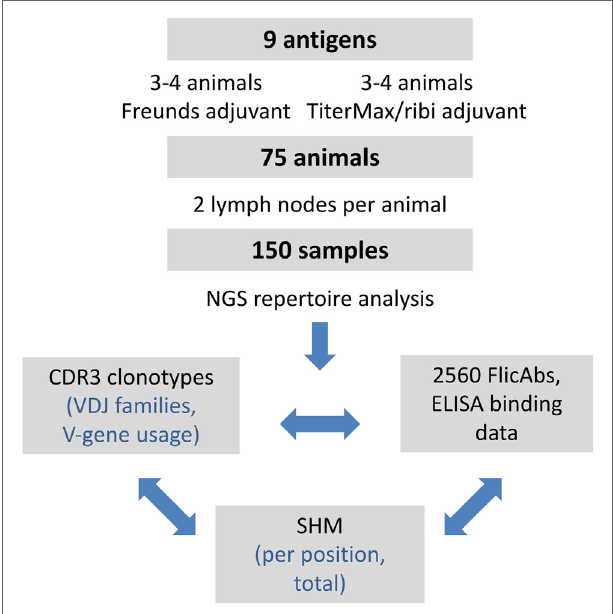
FigUre 1 | Summary of experimental design and analysis. The overall design of the project and subsequent analyses is shown. We performed a series of immunizations with 9 different antigens and included 75 different OmniFlic animals. We harvested 2 lymph nodes from each animal for a total of 150 different samples. Our analysis was focused on three areas: VDJ clonotype diversity by NGS, somatic hypermutation by NGS, and antigen binding by